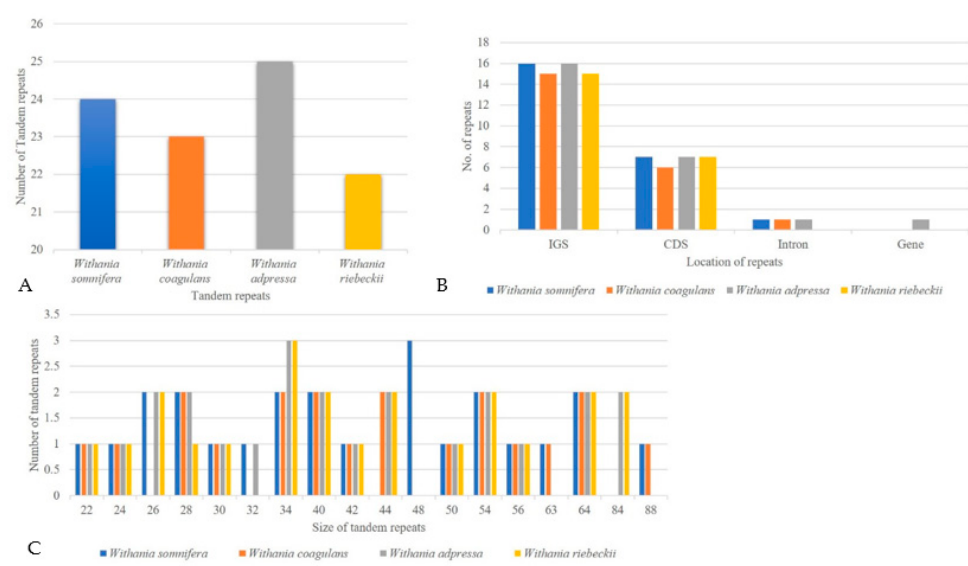
Figure 7. The assessment of tandem repeats ( A ) The total number of tandem repeats and ( B ) their distribution among functional regions of the plastome. ( C ) Tandem repeat number, size, and distribution.